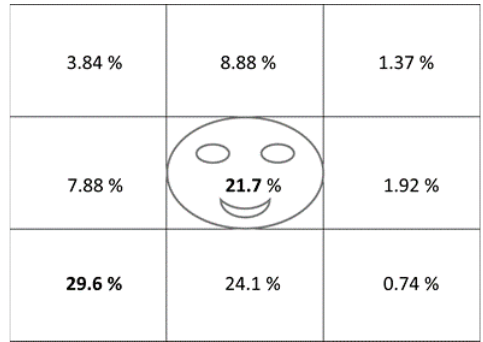
Figure 5 . At the 21.7% of the dwell time, participants looked at interlocutor’s face. The bottom left corner with the 29.6% was the most sighted